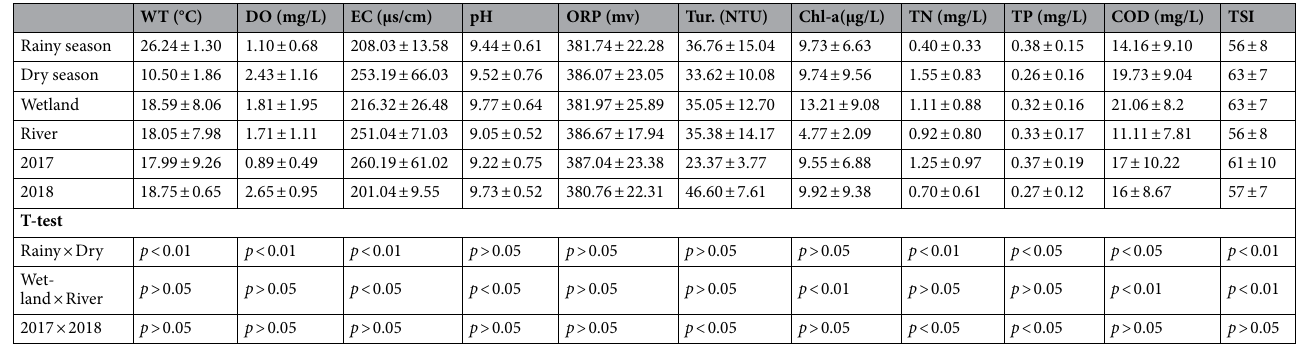
Table 1. The temporal and spatial variation of environmental parameters and TSI during study